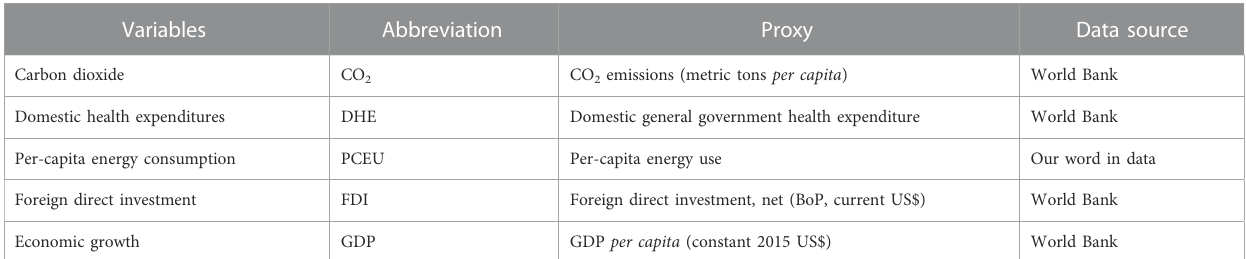
TABLE 1 Description of the study variables.